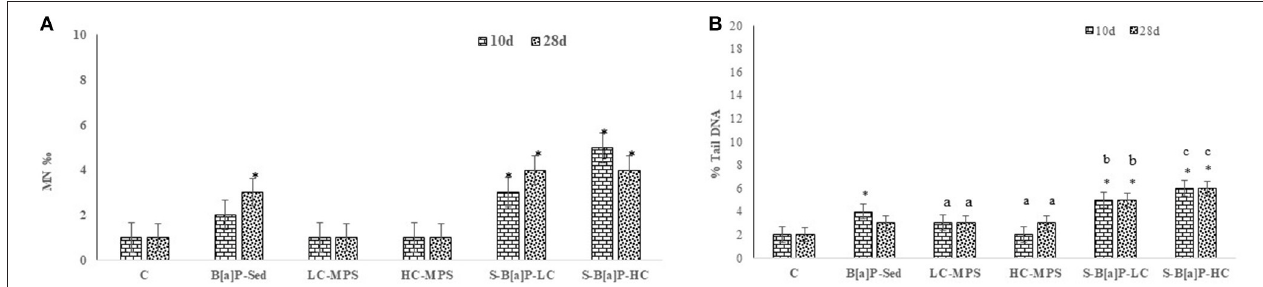
FIGURE 2 | Genotoxicity assessment in coelomocytes of H. diversicolor exposed to uncontaminated sediments (C), D sediments spiked with 1 mg/L B[a]P (S-B[a]P), sediments spiked with 200 and 2000 particles/kg virgin PVC (LC-MPS, HC-MPS) and sediments with B[a]P spiked microplastic particles (B[a]P-LC: 200 particles/kg.; B[a]P-HC: 2000 particles/kg). (A) Microunuceli frequency, (B) DNA strand breaks. * p < 0.05. Data are expressed as mean values ± standard deviation, n = 4. Different letters indicate significant differences between groups of means ( post-hoc comparison).